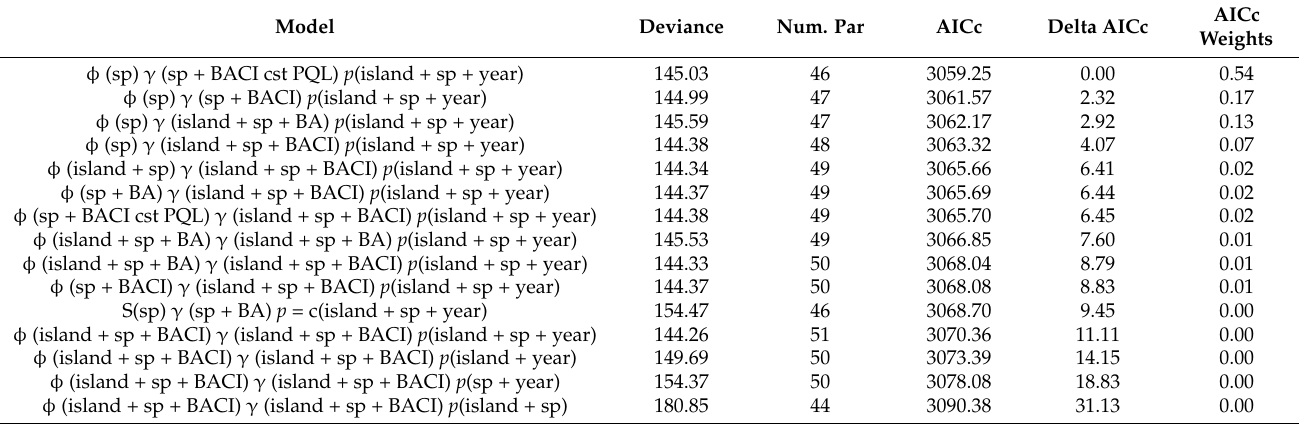
Table 1. Model selection statistics for the capture-recapture models used to estimate the demographic parameters of snakes of Porquerolles and Port-Cros islands from 2012 to 2019. φ is the survival probability, γ the seniority probability, p is the capture and recapture probability. Year means that a yearly variation was fitted on the parameter, sp an effect of species, island and effect of island, BACI means an interaction between island and time (before 2016 vs. after 2016), BA means “before 2016 versus after 2016” and “cst PQL” means that only the estimates of Port-Cros after 2016 differ from all others transitions.